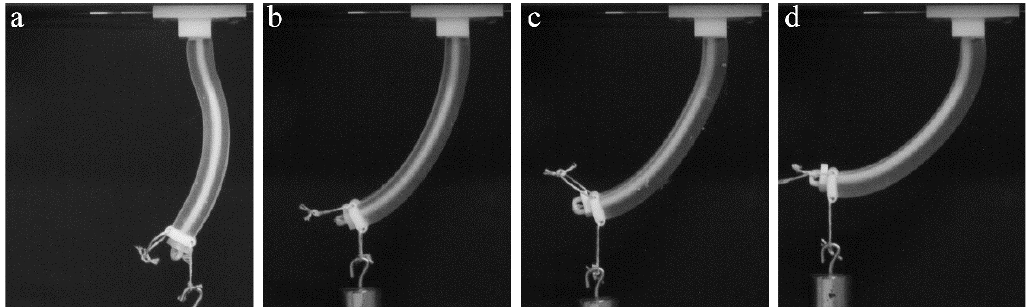
Figure 6. Experimental snapshots for TangoPlus actuators with central channel ( a ) and the channel shifted 1 ( b ), 2 ( c ), and 3 mm ( d ) from the central position. Additional weight is attached to the free end of the actuator in order to estimate their lifting capacity. The deformed shape corresponds to the cable retraction length of 20 mm.